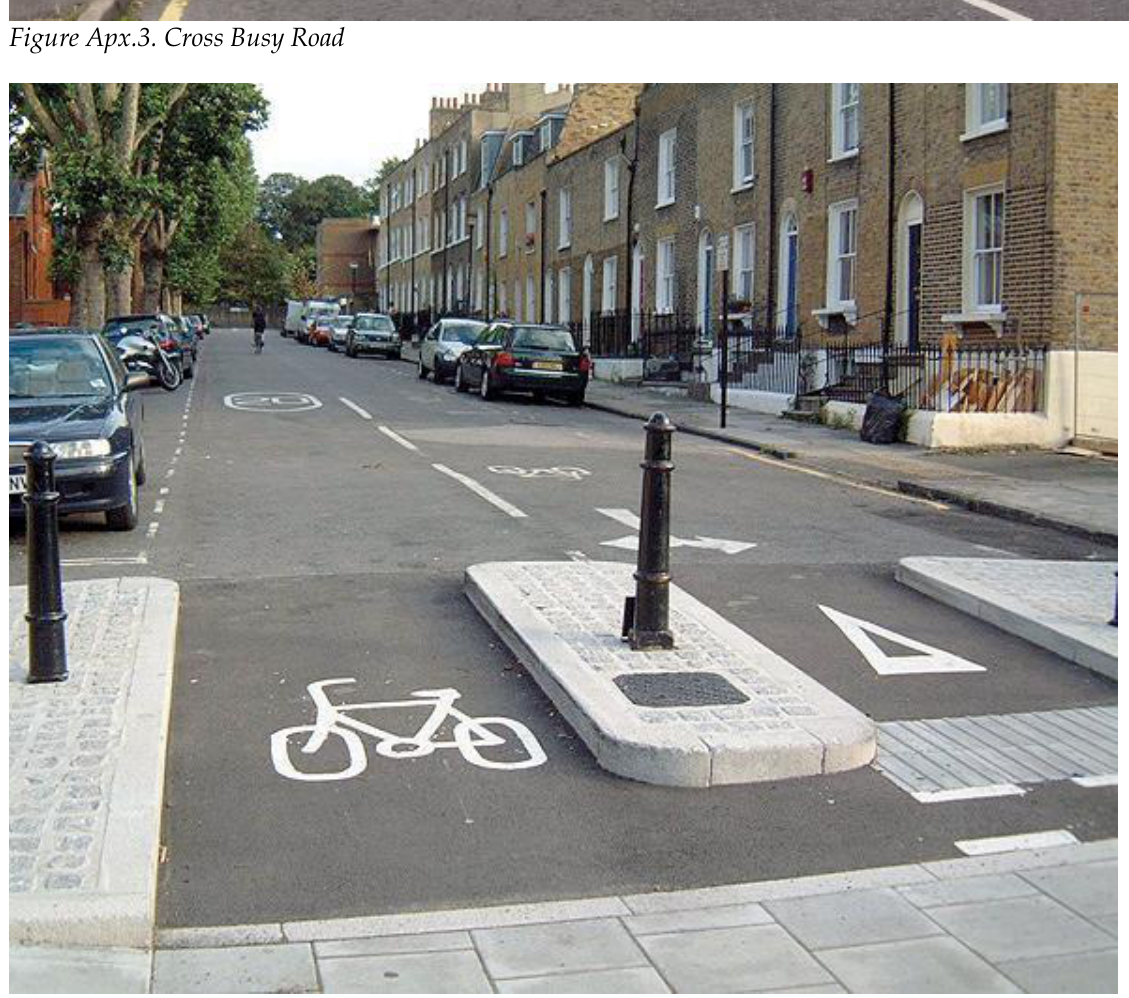
Figure Apx.4. Filtered